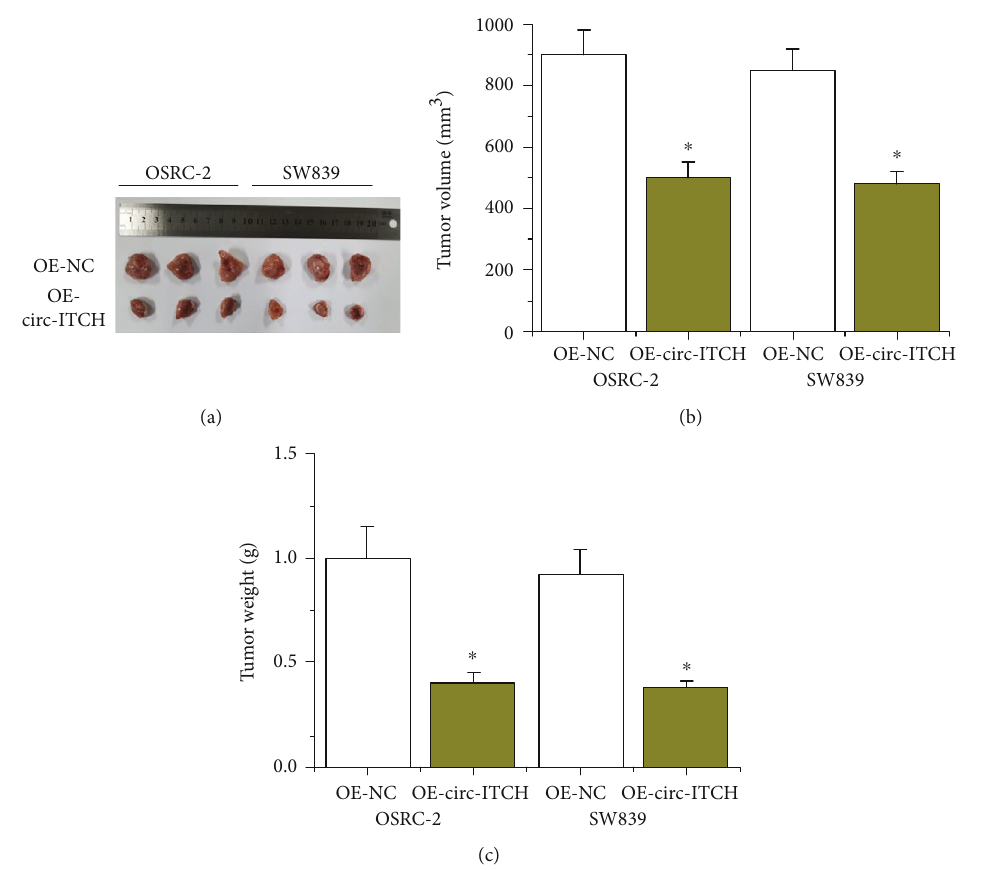
Figure 4: circ-ITCH exerts oncogenic e ff ects of ccRCC cells in vivo. (a – c) Tumor specimens, volume, and weight in nude mice that injected with OE-circ-ITCH